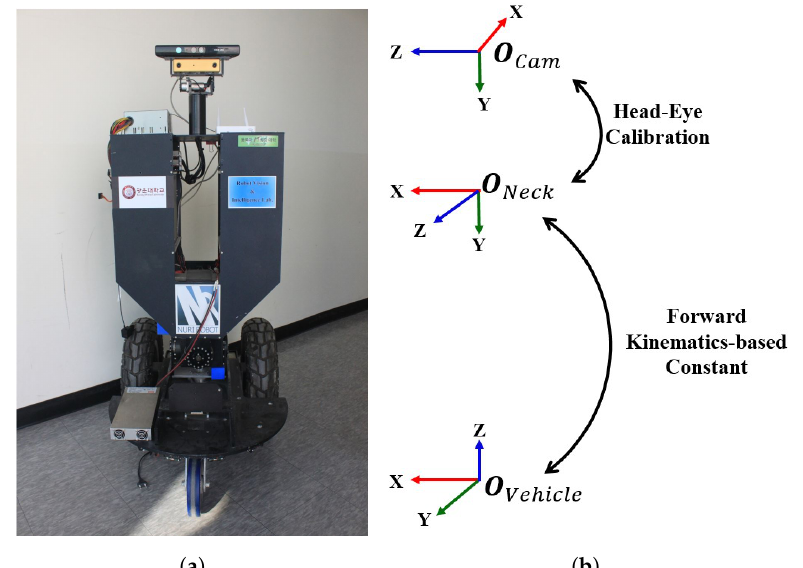
Figure 1. Mobile robot configuration. ( a ) Robot having a pan-tilt neck equipped with a camera (front-view); ( b ) coordinate system of mobile robot configuration